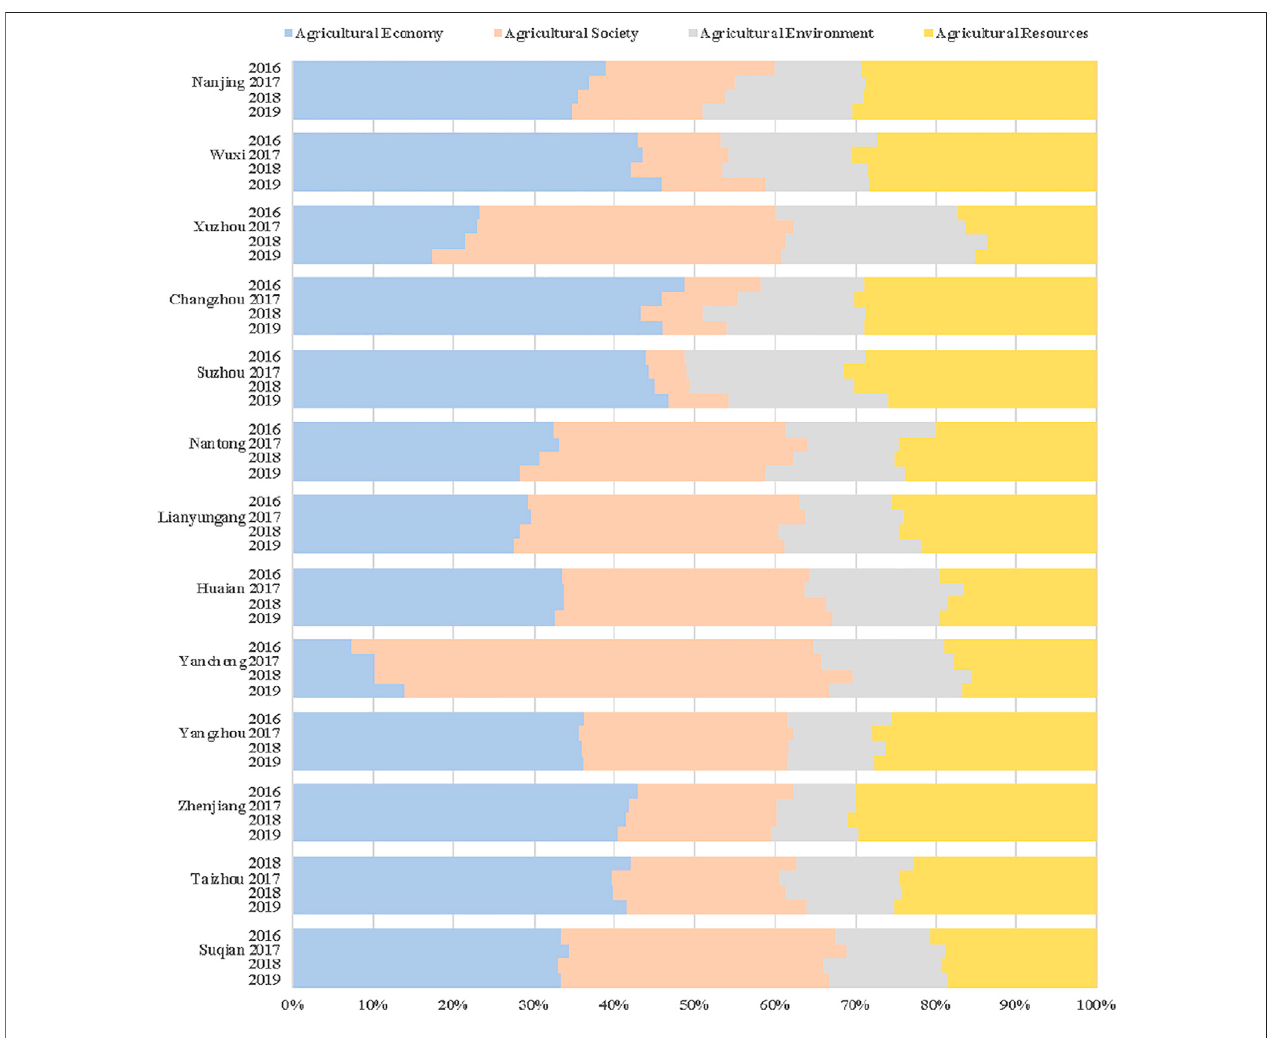
FIGURE 6 | Obstacle degree of fi rst-level indexes for sustainable agriculture in jiangsu province.